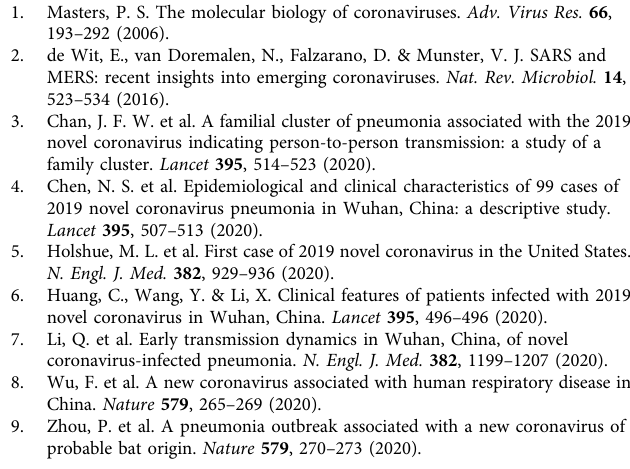
Fig. 3 Learning and diagnosis of clinical specimens. Both processes do not require RNA extraction from the virus. a Ionic current – time traces of the PCR- positive and PCR-negative saliva specimens. b , c Histograms of I p and t d of saliva specimens. The color code corresponds to a . I p and t d show the peak current and duration of the current of an ionic current waveform, respectively. d Learning process of PCR-positive and PCR-negative saliva specimens using the learning algorithm. In all, 40 PCR-positive and 40 PCR-negative saliva samples were used for learning. e Diagnosis process of PCR-positive and PCR-negative